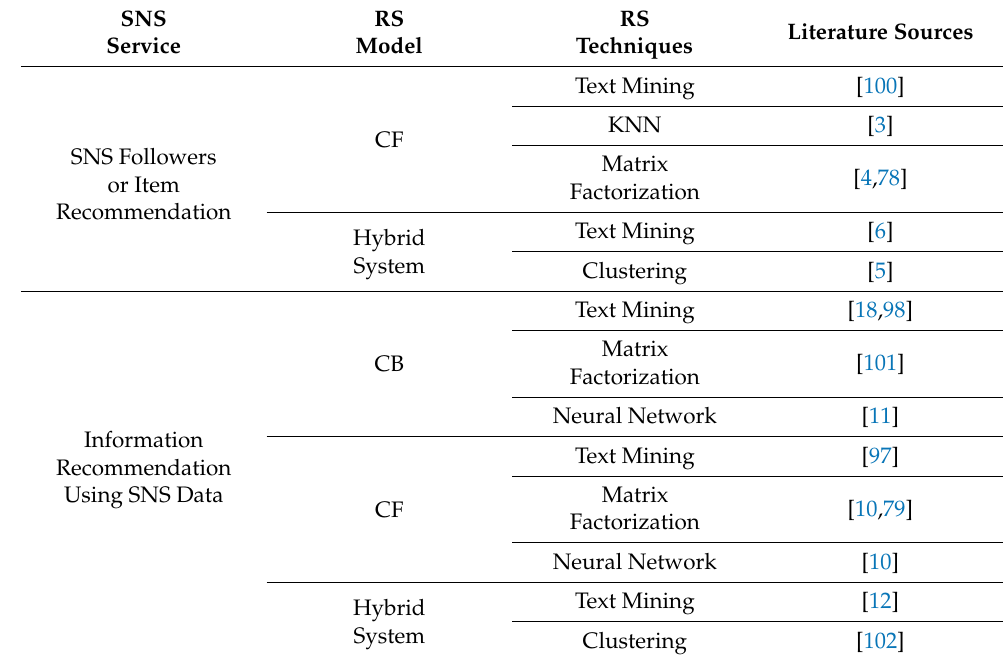
Table 6. Recommendation system study of social network service